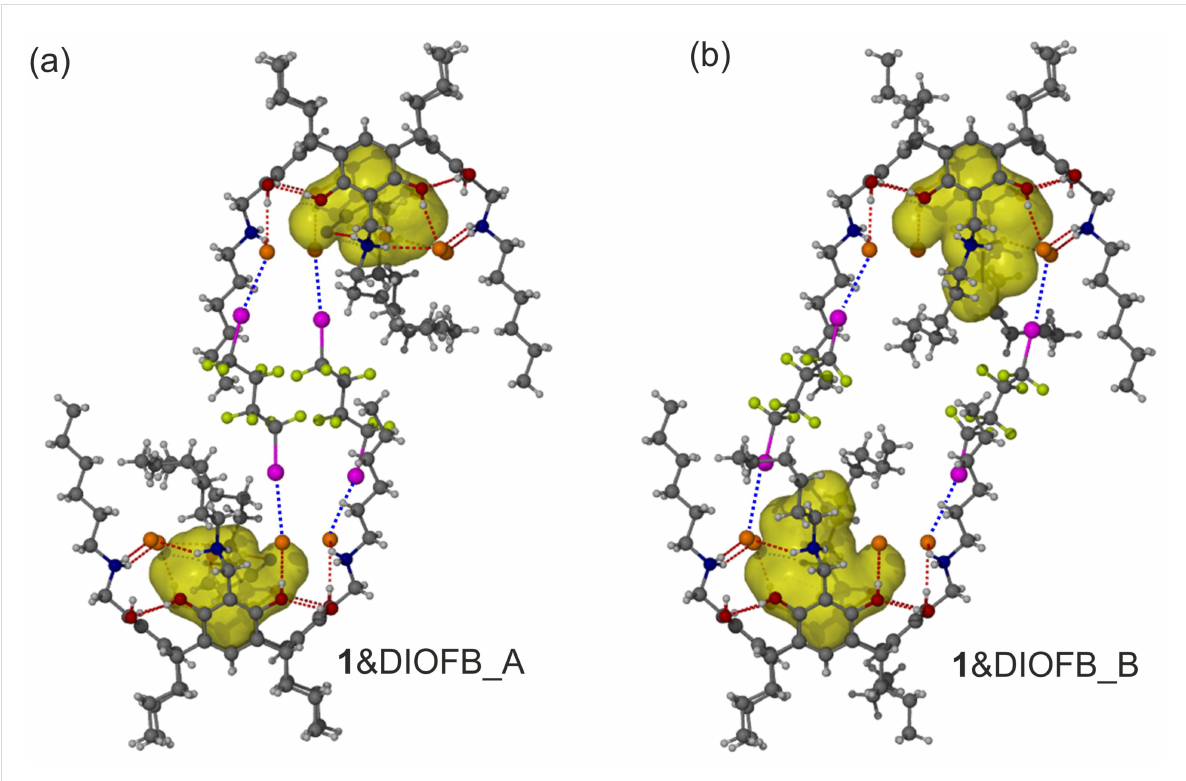
Figure 3: The two dimerization modes in the MeOH-MeCN@ 1 &DIOFB complex. In both modes, the cavities are shown as transparent yellow cloud.